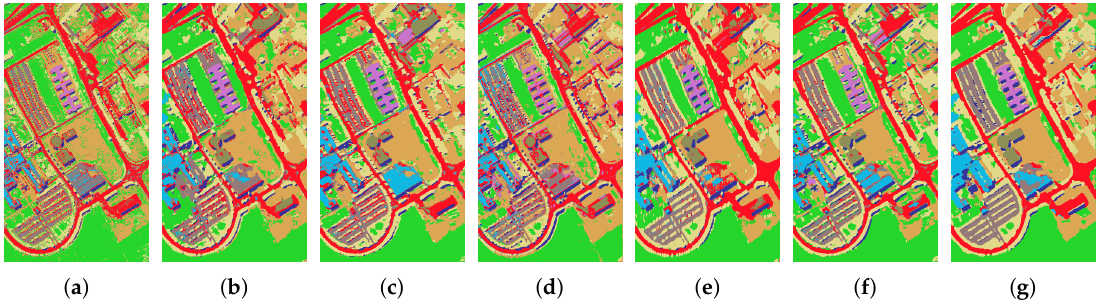
Figure 9. The classification maps of PaviaU: ( a ) P-SVM-RBF, ( b ) P-CNN, ( c ) CRNN, ( d ) 3-D-CNN, ( e ) 3-D-CNN-LSTM, ( f ) L-CLSTM, and ( g ) PRCLSTM.